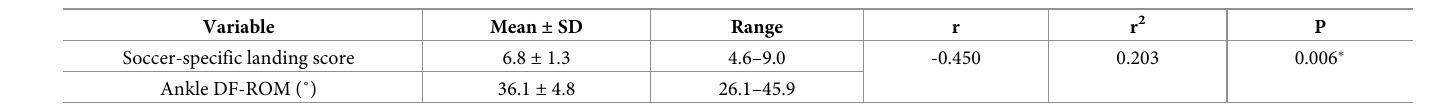
Table 2. The results of Pearson correlation test.